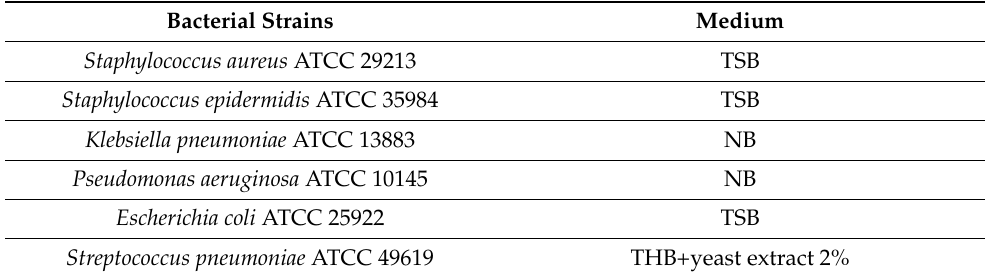
Table 1. Bacterial type strains and the corresponding culture medium